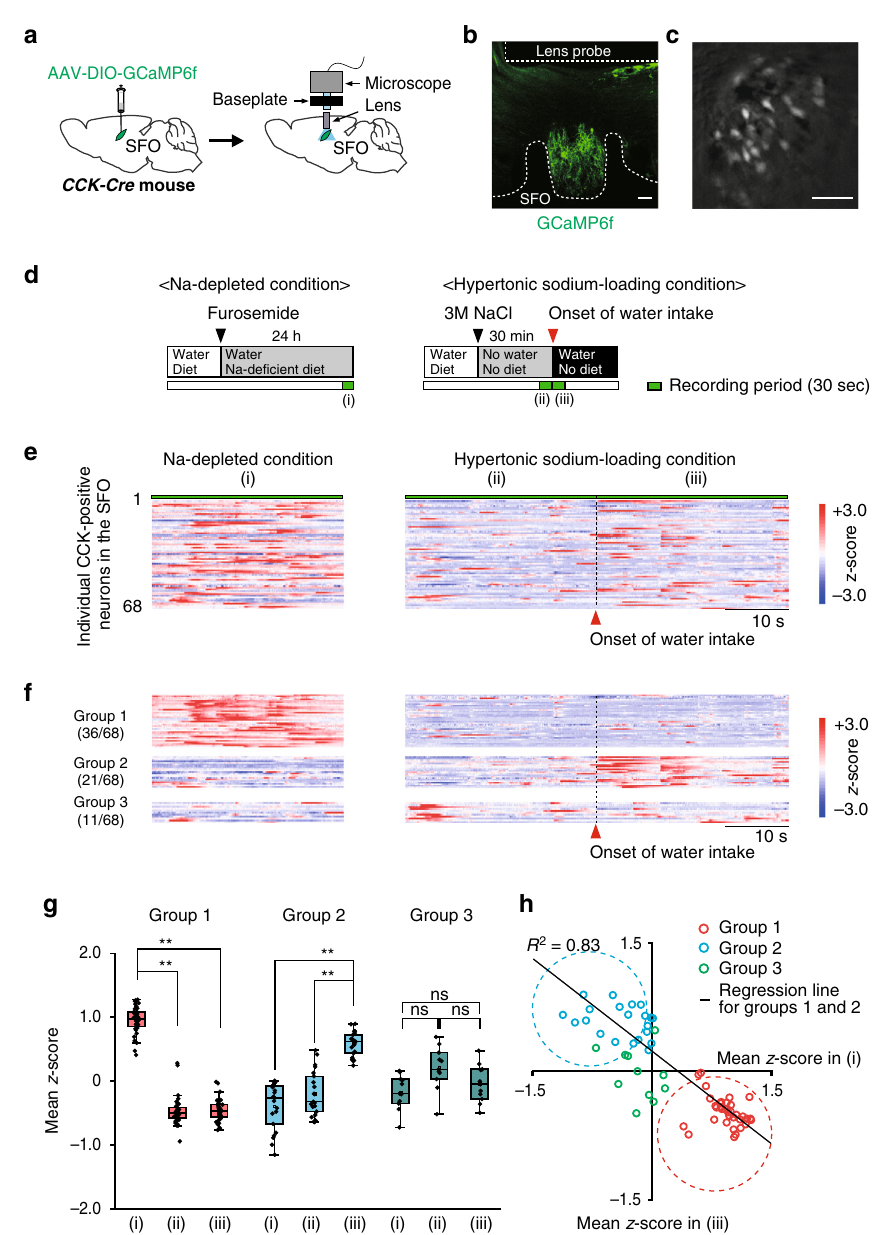
Fig. 3 Distinct subpopulations of CCK-positive neurons are activated in the SFO under the Na-depleted condition or in response to water intake. a Injection of AAV-DIO-GCaMP6f into the SFO of the CCK-Cre mouse. GCaMP6f-expressing neurons were imaged through a GRIN lens targeting the SFO. b Placement of the GRIN lens above the SFO and immunohistochemical staining of GCaMP6f in CCK-positive neurons in the SFO. Scale bar, 30 µ m. c Representative fl uorescence-microscopic image of CCK-positive neurons. Scale bar, 30 µ m. The images in ( b ) and ( c ) were reproduced from two independent mice. d Experimental protocols for Ca 2 + imaging of CCK-positive neurons (i) under the Na-depleted condition (left), (ii) under the hypertonic sodium-loading condition (right), and (iii) following the onset of water intake (right). e Raster plots of z -scored calcium responses in individual CCK- positive neurons during each condition ( n = 68 neurons in two mice). f K-means clustering of individual CCK-positive neurons based on their activities under each condition. Three distinct subpopulations of CCK-positive neurons (group 1, group 2, and group 3) were identi fi ed in the SFO. g Dot plot of the mean z -score of individual CCK-positive neurons in group 1 (left), group 2 (middle), and group 3 (right). n = 68 neurons in two mice. ** P < 0.01; ns, not signi fi cant; two-sided one-way RM ANOVA (group 1, F(2,34) = 380.9, P = 5.26 × 10 − 10 ; group 2, F(2,19) = 97.17, P = 1.51 × 10 − 10 ; group 3, F(2,9) = 2.524, P = 0.135) with the post hoc two-sided paired Student ’ s t -tests (group 1, P (i vs ii) = 1.15 × 10 − 21 , P (i vs iii) = 5.11 × 10 − 25 ; group 2, P = 6.68 × 10 − 9 , P = 6.58 × 10 − 8 ). Box-plot elements (center line, upper and lower box limits, whiskers, and points) were de fi ned as medians, (i vs iii) (ii vs iii) quartiles, 1.5× interquartile ranges, and outliers. h Relationship between the mean z -scores of individual neurons under (i) the Na-depleted condition